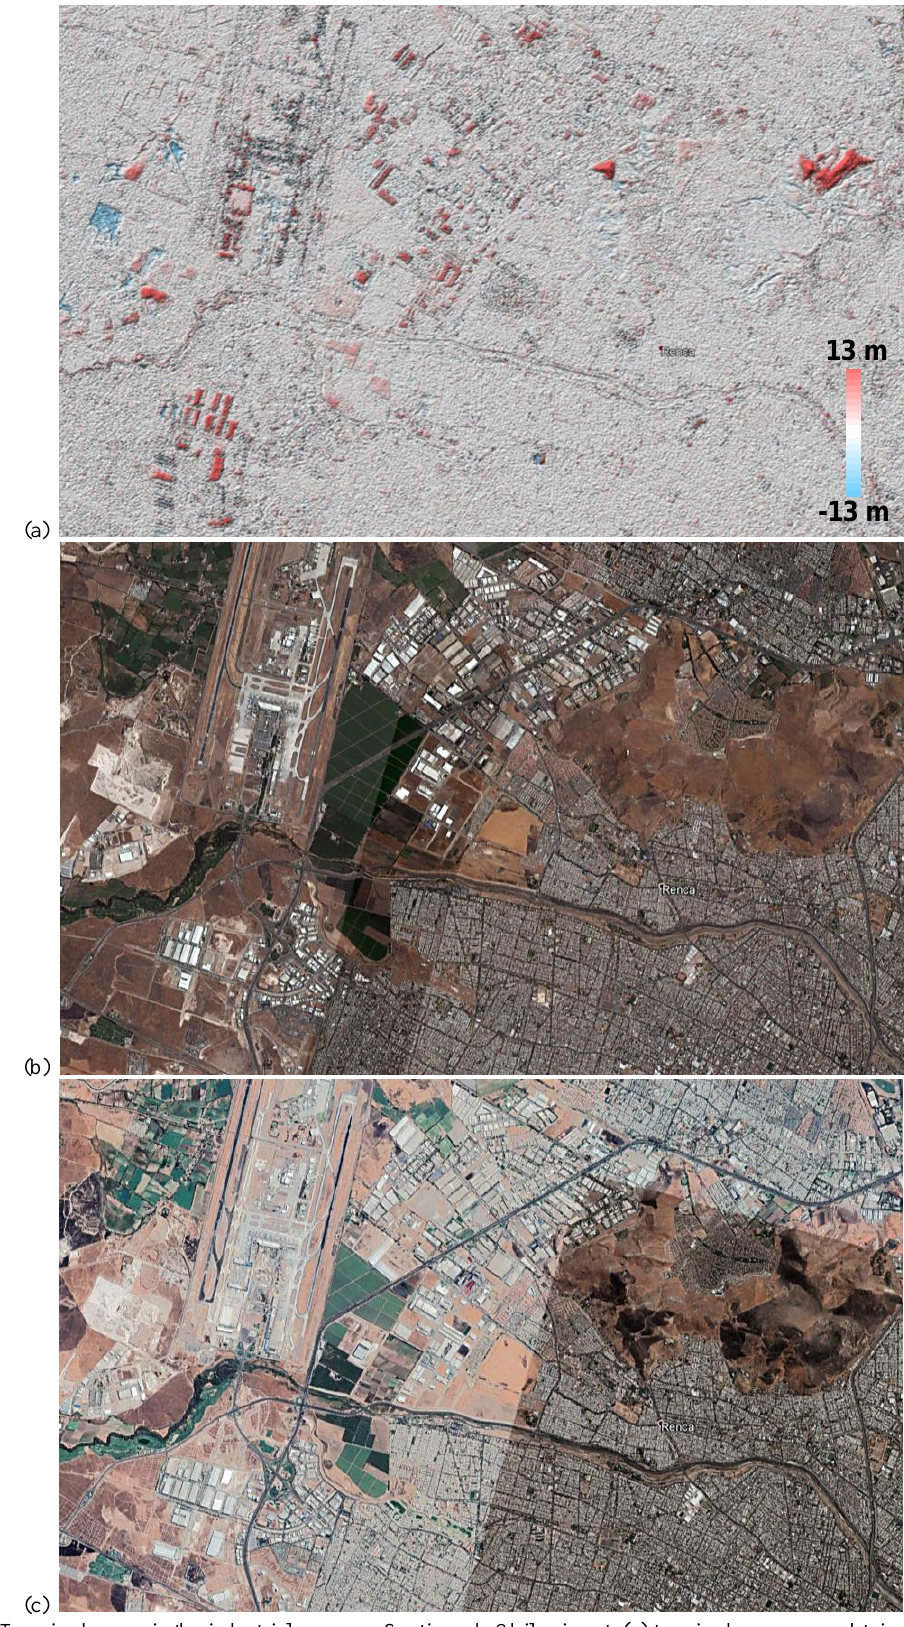
Figure 5. Terrain changes in the industrial area near Santiago de Chile airport: (a) terrain changes map obtained during the interferometric processing of a scene of the Change DEM acquisition (from 30/04/2018); (b) Google Earth photo (Google, Maxar technologies) from 24/02/2015 i.e. taken after the end of the acquisitions for the global TanDEM-X DEM; (c) Google Earth photo (Google, Maxar technologies) from 05/05/2018 i.e. after the Change DEM